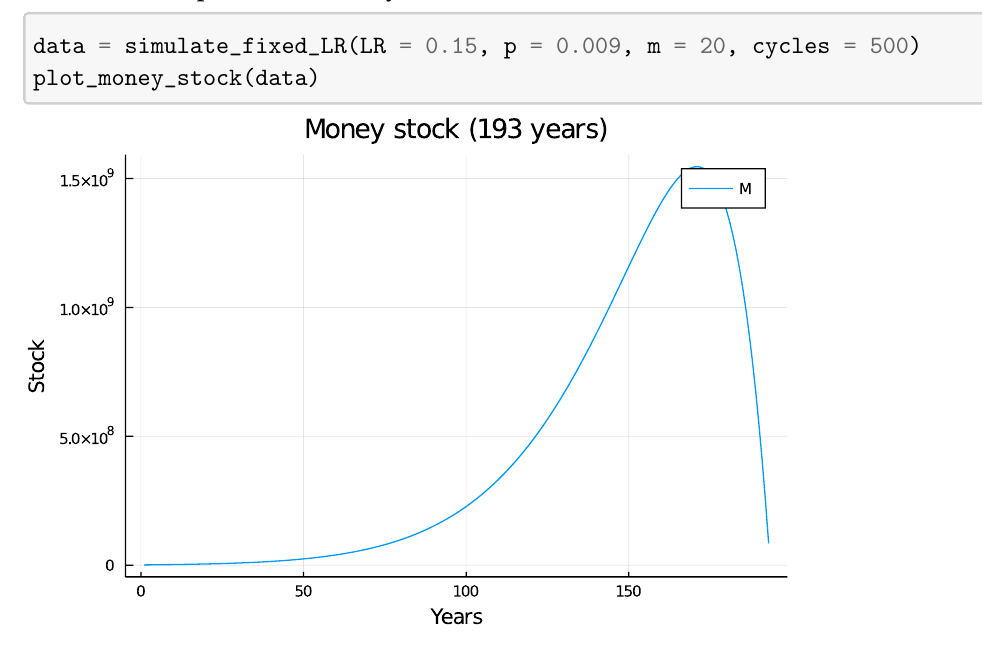
Figure 11. Money stock (LR = 15%, p = 0.9%, m = 20 years).